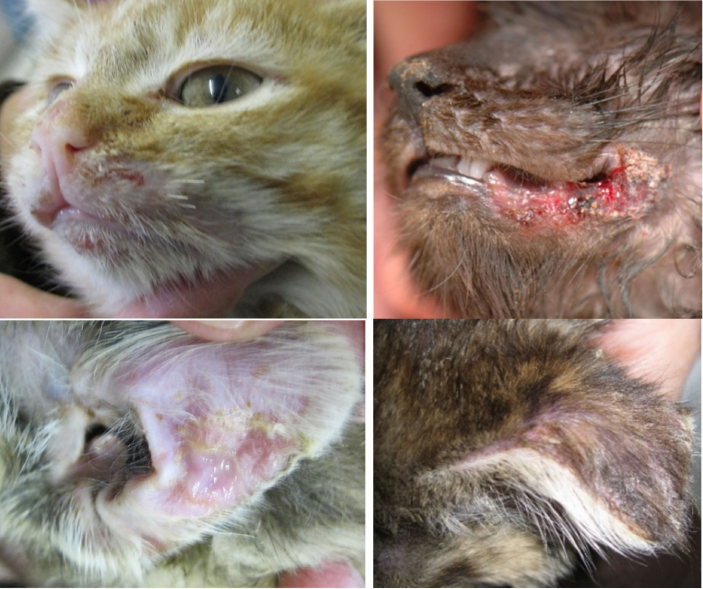
Figure 8. Crusted lesions and ulcers of cats with VS-FCV infection: facial, mucocutaneous (lower lip and commissure) and ears. ©University Animal Hospital Zurich, Regina Hofmann-Lehmann. Not all cats with VS-FCV infection show all the typical clinical signs, which makes it difficult to recognize all affected cats.